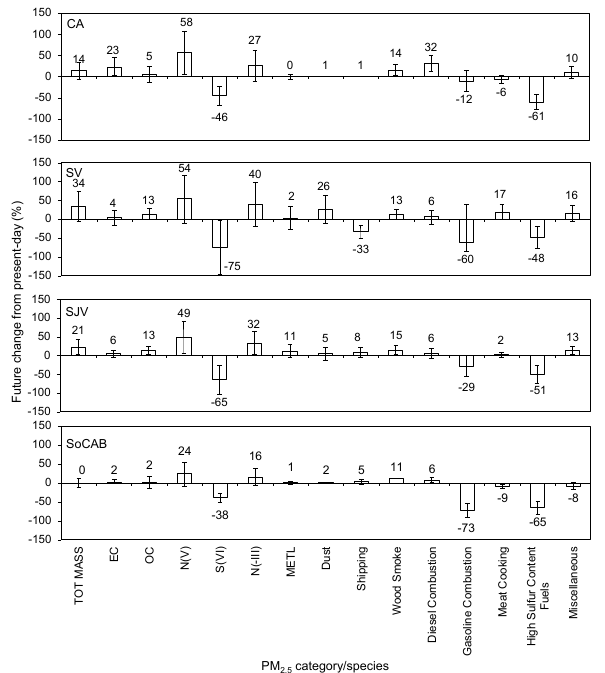
Fig. 5. Change in population-weighted extreme concentrations of PM 2.5 total mass, primary and secondary components, and source categories contributing to the total mass between future (2047-2053) and present-day (2000-06). Values are the changes in the ten-year return levels which are the maximum 24-hr average concentration experienced in a ten year period. Panels (top-down) show California state-wide average, Sacramento Valley (SV) air basin average, San Joaquin Valley (SJV) air basin average, and South Coast Air Basin (SoCAB) average results. The error bars represent the lower and upper limits of the 90% CI.